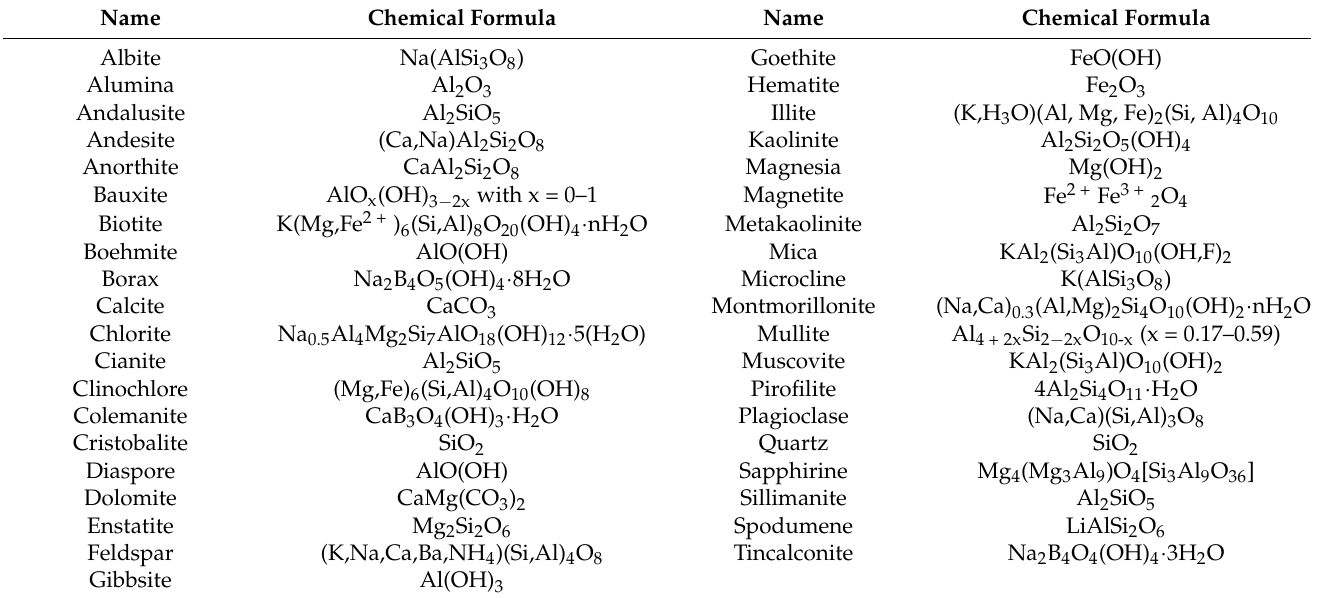
Table A1. Alphabetical list of minerals and crystalline